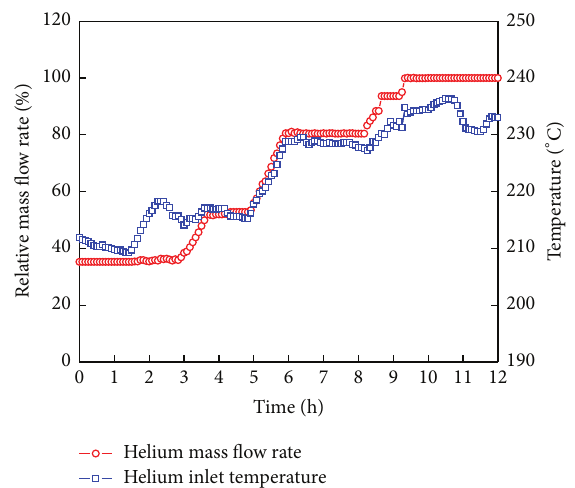
Figure 6: Helium mass flow rate and helium inlet temperature during the test.